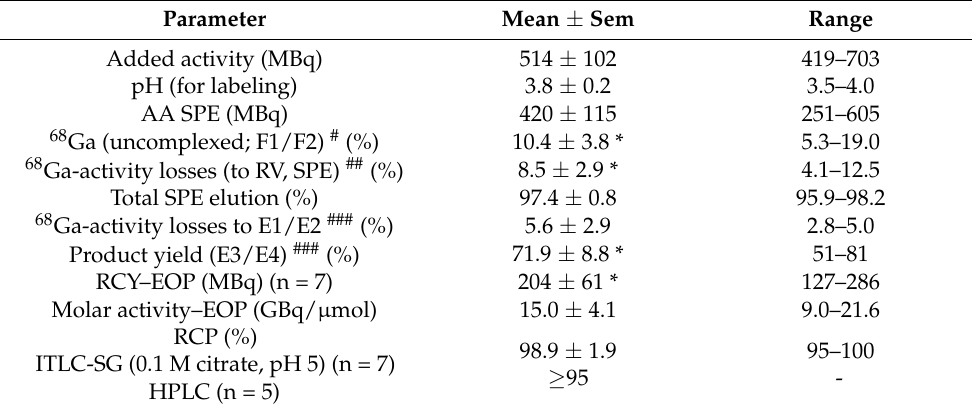
Table 3. Overview of the SPE purification performance applicable to non-quantitative preparation